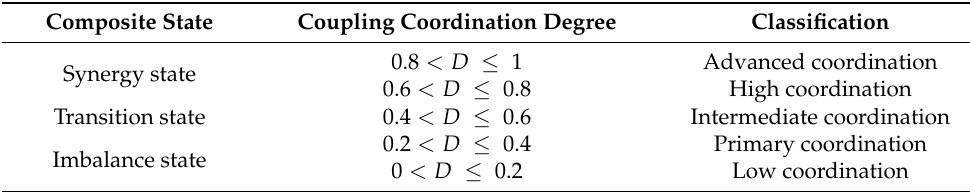
Table 2. The classification of the coupling coordination